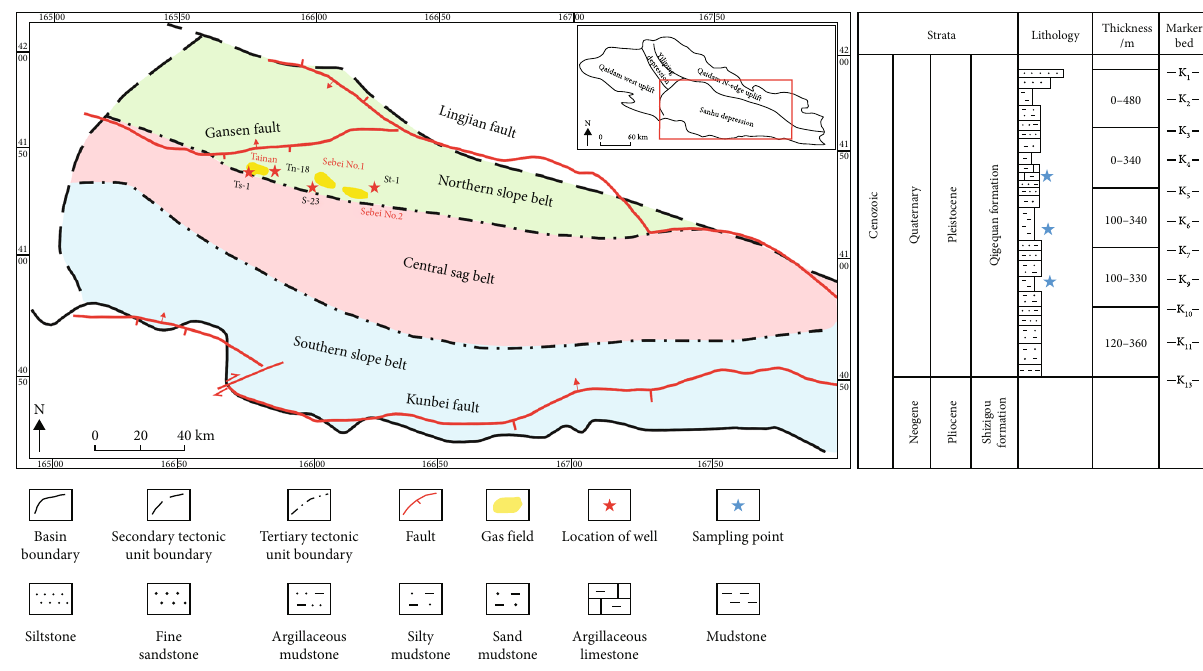
Figure 1: The structure of the Sanhu Depression and the histogram of Quaternary stratigraphy. Sanhu Depression is divided into the southern slope belt, central sag belt, and northern slope belt. The gas fi eld is located in the northern slope belt. The experimental samples were taken from wells Tn-18, Ts-1, St-1, and